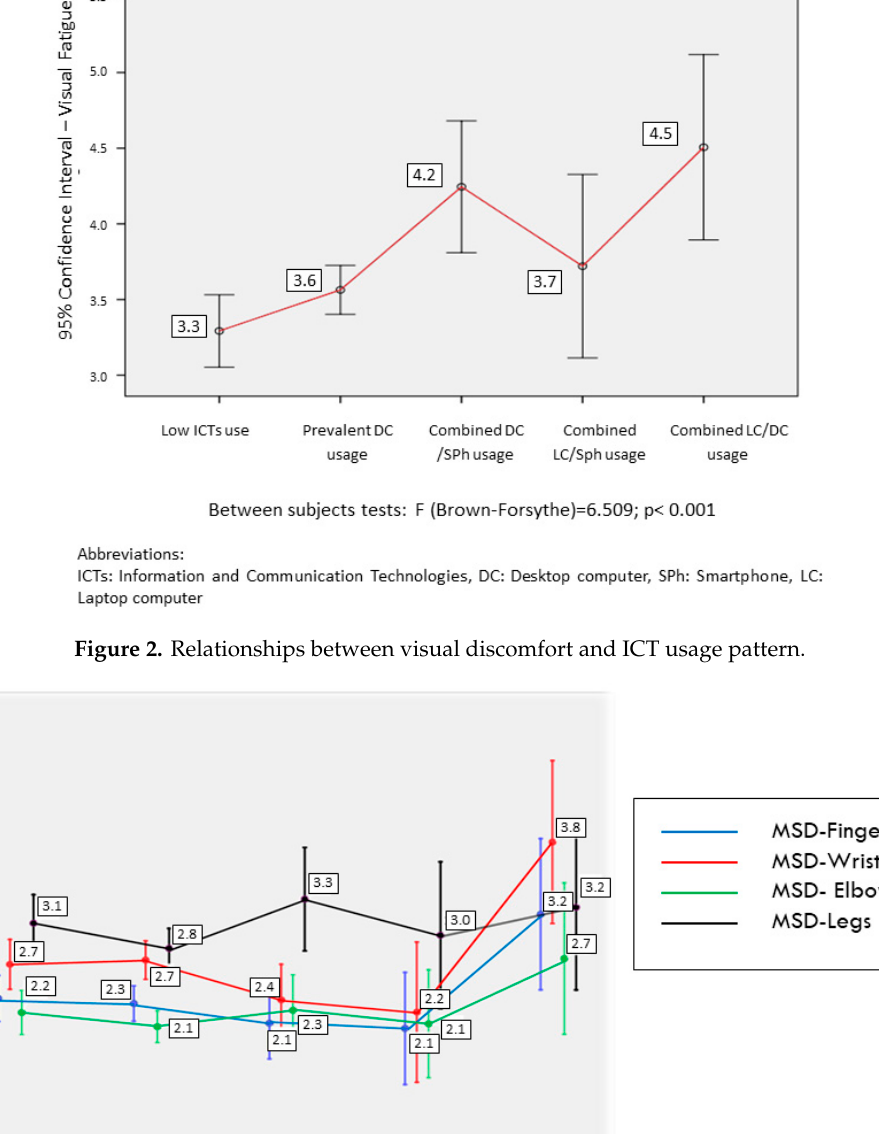
Figure 3. Relationships between MSDs and ICT usage pattern (1).